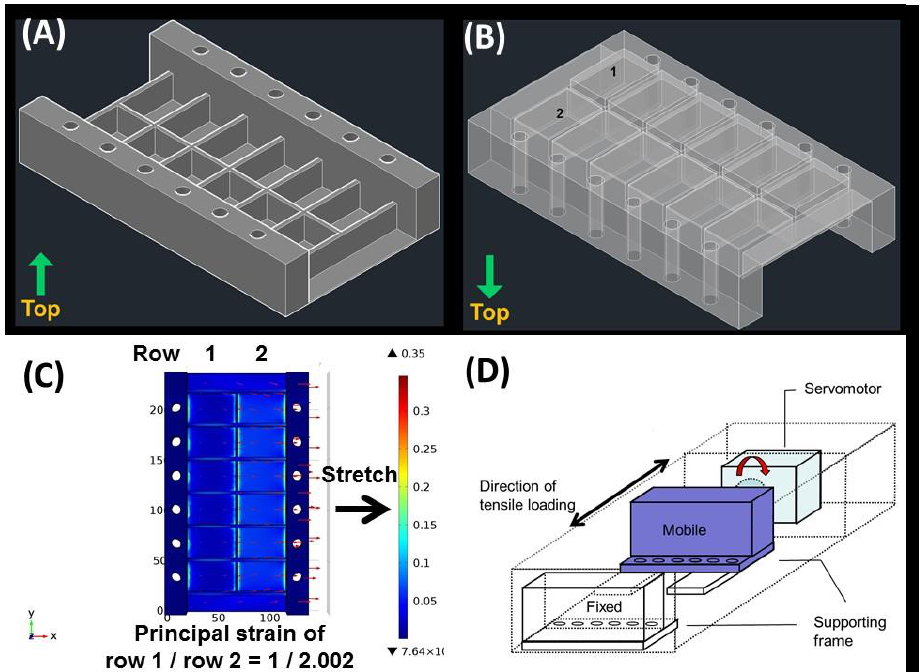
Figure 4. Effect of piracetam on the gene expression of tendon-derived cells (TDCs) subjected to cyclic stretching with 8% strain. Upper panel : Quantitative PCR demonstrated that TDCs with piracetam showed decreased expression of type III collagen genes compared with cells without piracetam. The difference in type III/type I ratio between groups was not significant. Lower panel : TDCs with piracetam showed decreased expression of Pparg , Runx2 , and Sox9 compared with cells without piracetam. Data are expressed in fold-changes of expression level relative to the control (static culture) and presented as mean ± SD ( n = 4, * p < 0.05).